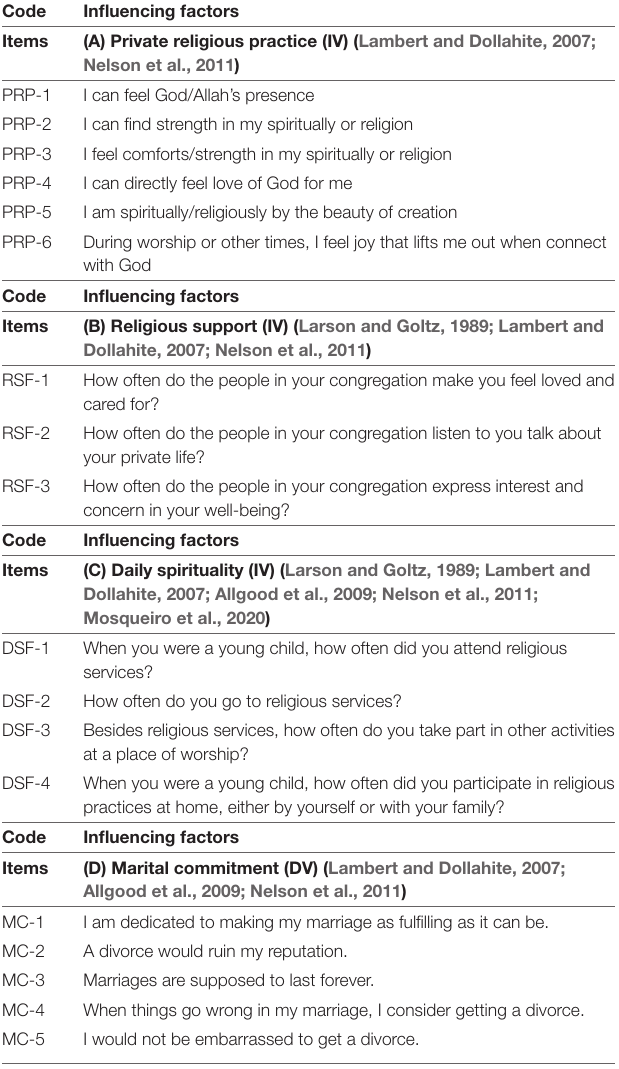
TABLE 3 | The identified factors list that influence marital